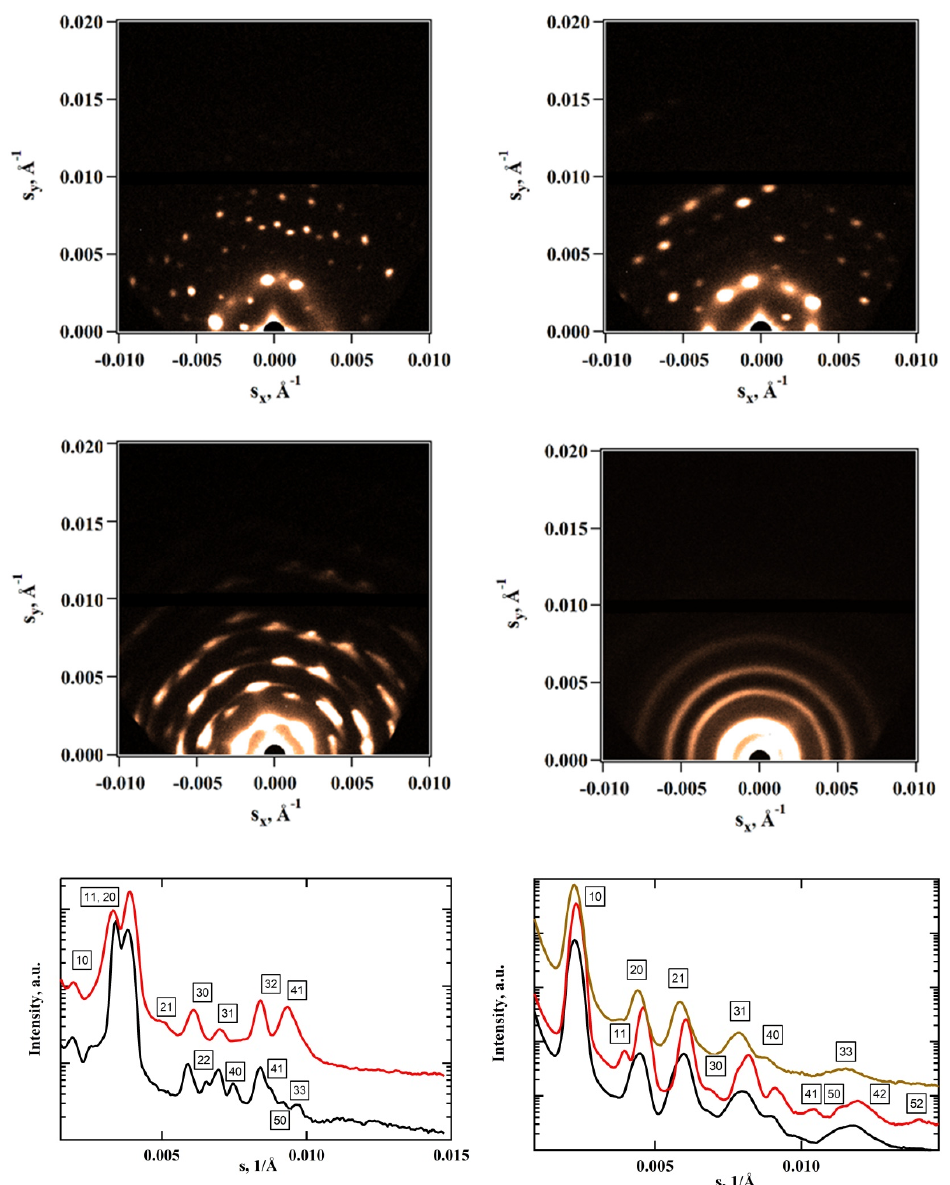
Figure 5. Two-dimensional SAXS patterns of the sample SI cast from THF at R.T. ( top left ) and subsequently annealed at 80 °C ( top right ), as well as the sample SEP cast from THF at R.T. and subsequently annealed at 80 °C ( middle left ), and the same sample annealed at 120 °C ( middle right ). The 1D-reduced data corresponding to samples SI and SEP described above are given in the bottom left and bottom right panels, respectively. In the bottom graphs, the as-prepared samples are shown in black, the ones annealed at 80 °C in red and at 120 °C in brown. The hk indices of the hexagonal lattice are indicated in 1D curves.